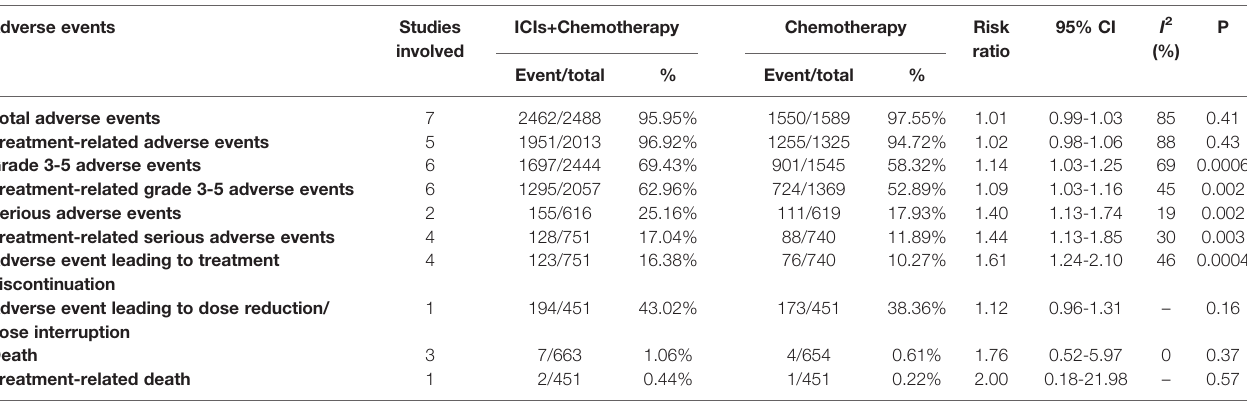
TABLE 3 | Summary of adverse